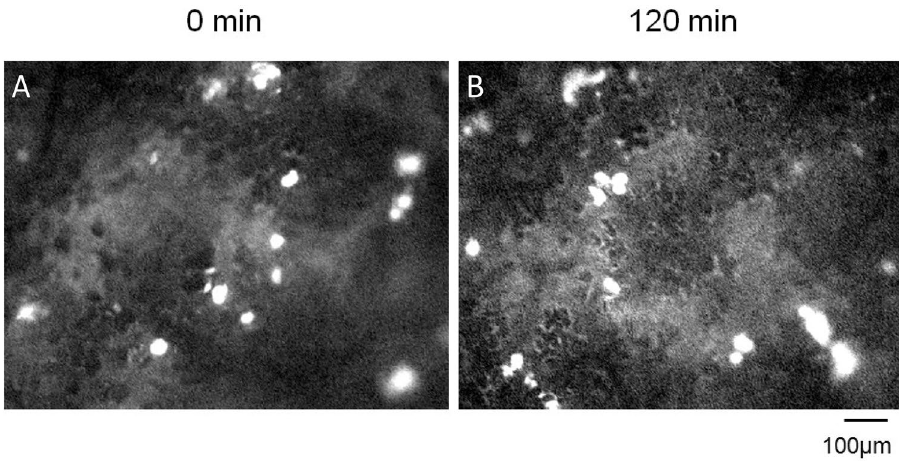
Figure 4. Administration of a FITC-labelled Dextran solution demonstrated the position of trapped MSCs in the pulmonary vasculature. Detection of FITC-labelled Dextran almost immediately after administration indicated that the MSCs were located in the post-arterial but not pre-venular capillaries ( A ). Cell position did not change 120 min after their infusion ( B ). FITC: Fluorescein isothiocyanate; MSC: Mesenchymal Stem Cell; Note : Images taken from different animals at each